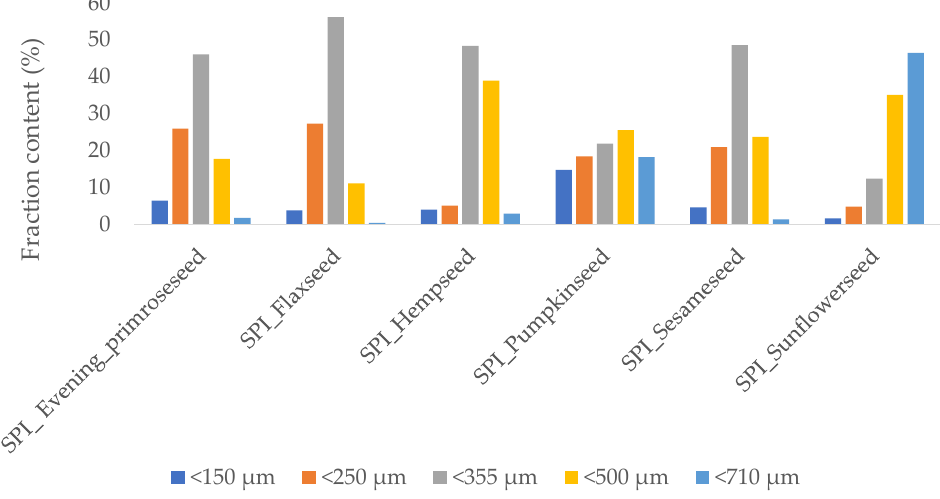
Figure 1. Fraction content in oilseed flours.